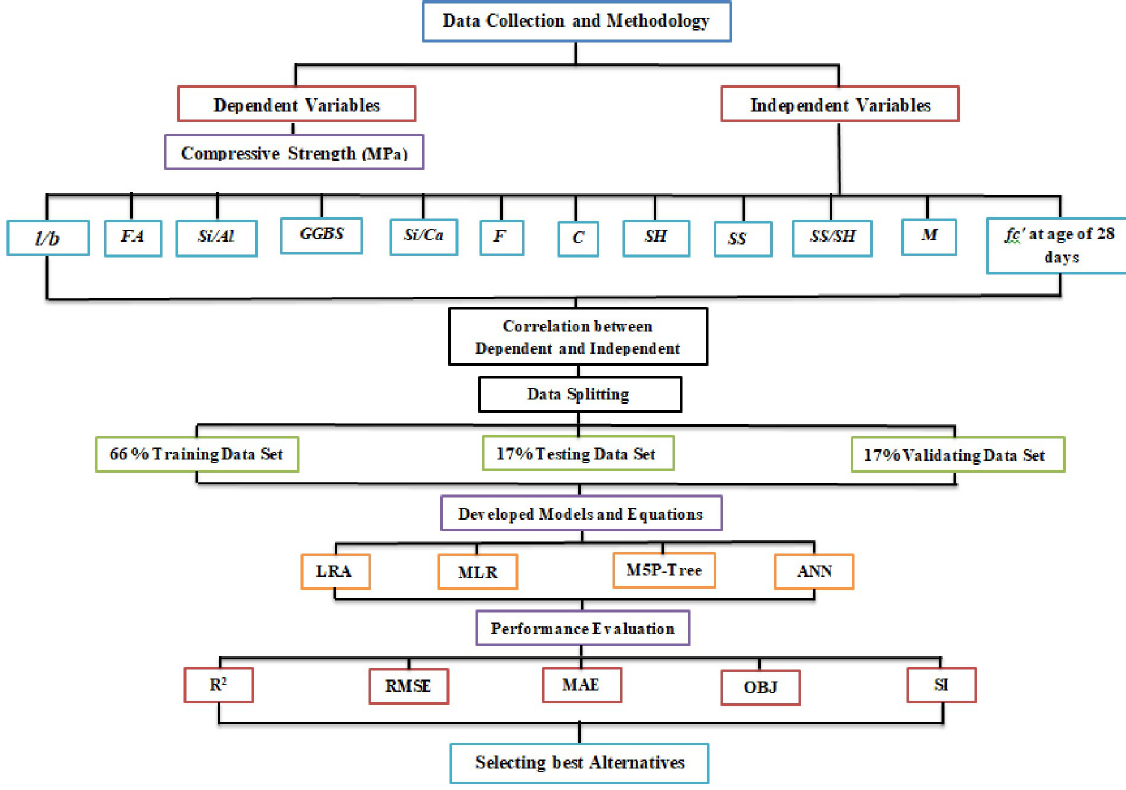
Fig 1. The flow chart diagram process followed in this